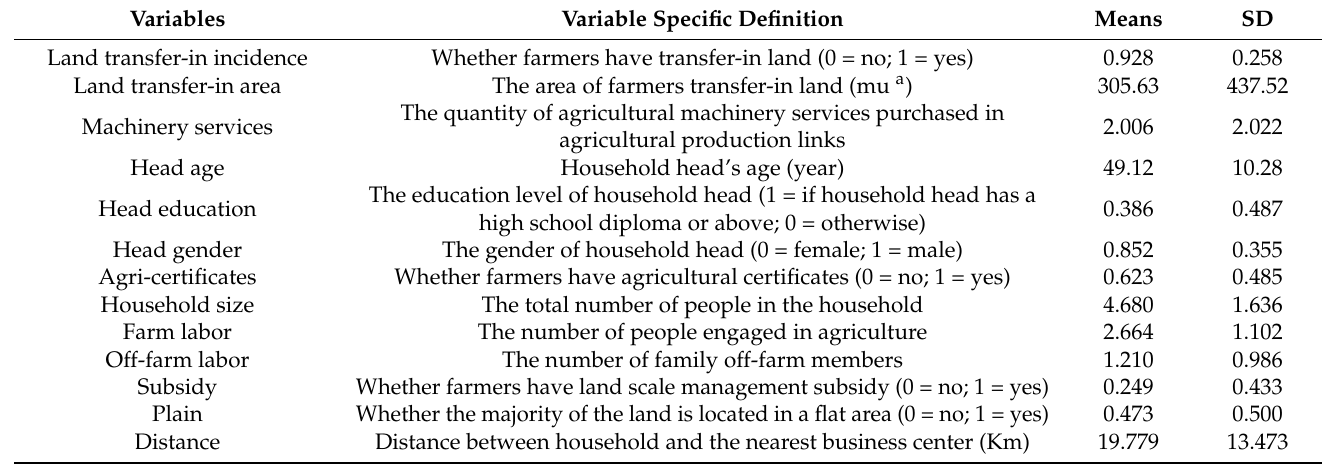
Table 1. Variables and descriptive